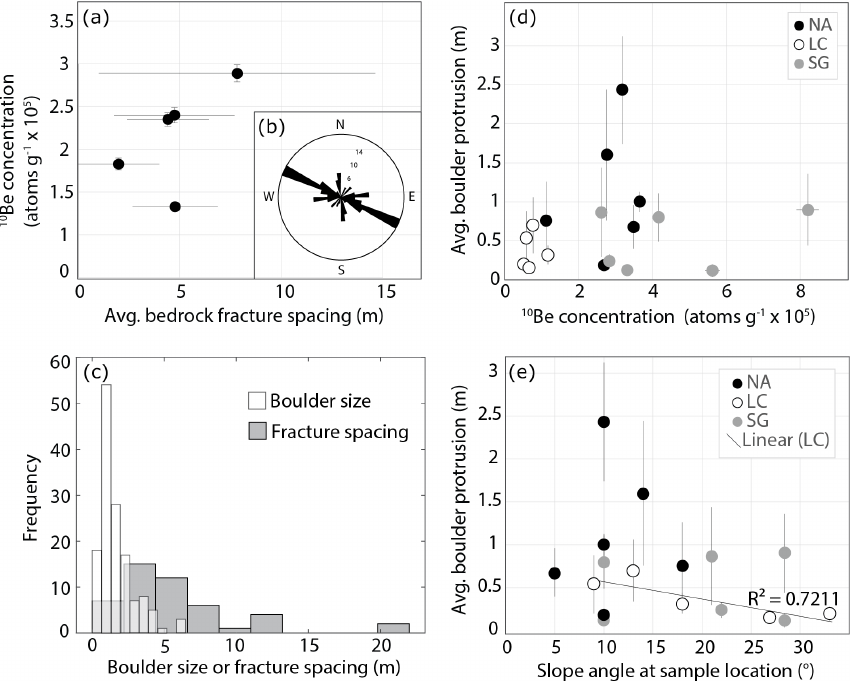
Figure 5. (a) Average bedrock fracture spacing (NA only), plotted against measured 10 Be concentrations normalized to the reference production rate at sea level high latitude. Error bars represent the standard deviation of all fracture spacing measurements for each location. (b) Rose diagram showing bedrock fracture orientations measured in the field in NA (same fractures as panel a ). (c) Measurements of individual fracture spacing and individual boulder sizes, with boulder size being the average of the x and y axes of each boulder and the z axis the protrusion height. (d) Average boulder protrusion height plotted against measured 10 Be concentrations normalized to the reference production rate at sea level high latitude for each field site. Error bars represent the standard deviation of all boulder protrusion height measurements for each location. (e) Average boulder protrusion height plotted against hillslope angle. A linear regression model is fit through LC data points.